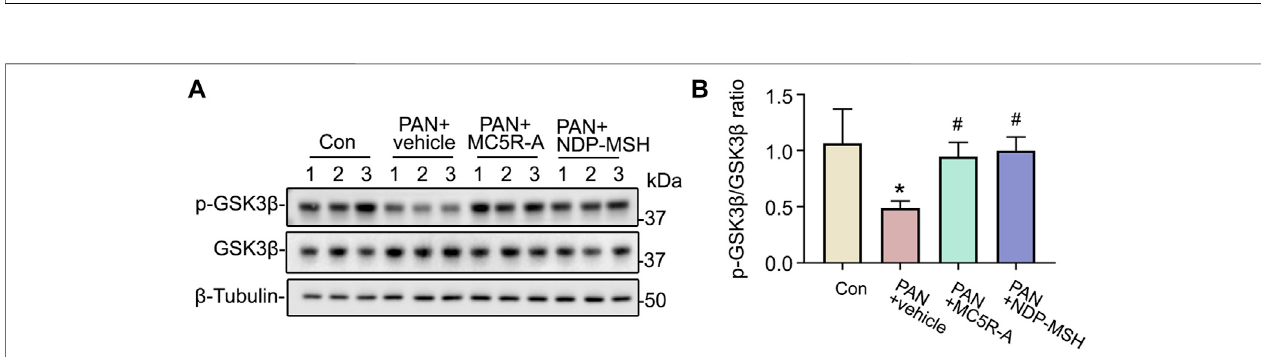
FIGURE 6 | MC5R agonist treatment reinstates inhibitory phosphorylation of GSK3 β . Cells were treated as elaborated in Figure 4. (A) Cells were lysed and processed for immunoblot analysis for p-GSK3 β , GSK3 β as well as β -tubulin, which served as the loading control. (B) Quanti fi cation of the p-GSK3 β and GSK3 β expression levels by densitometric analyses of immunoblots, expressed as relative levels normalized to GSK3 β . p p < 0.05 versus control (Con) group; # p < 0.05 versus PAN + vehicle group ( n = 3).